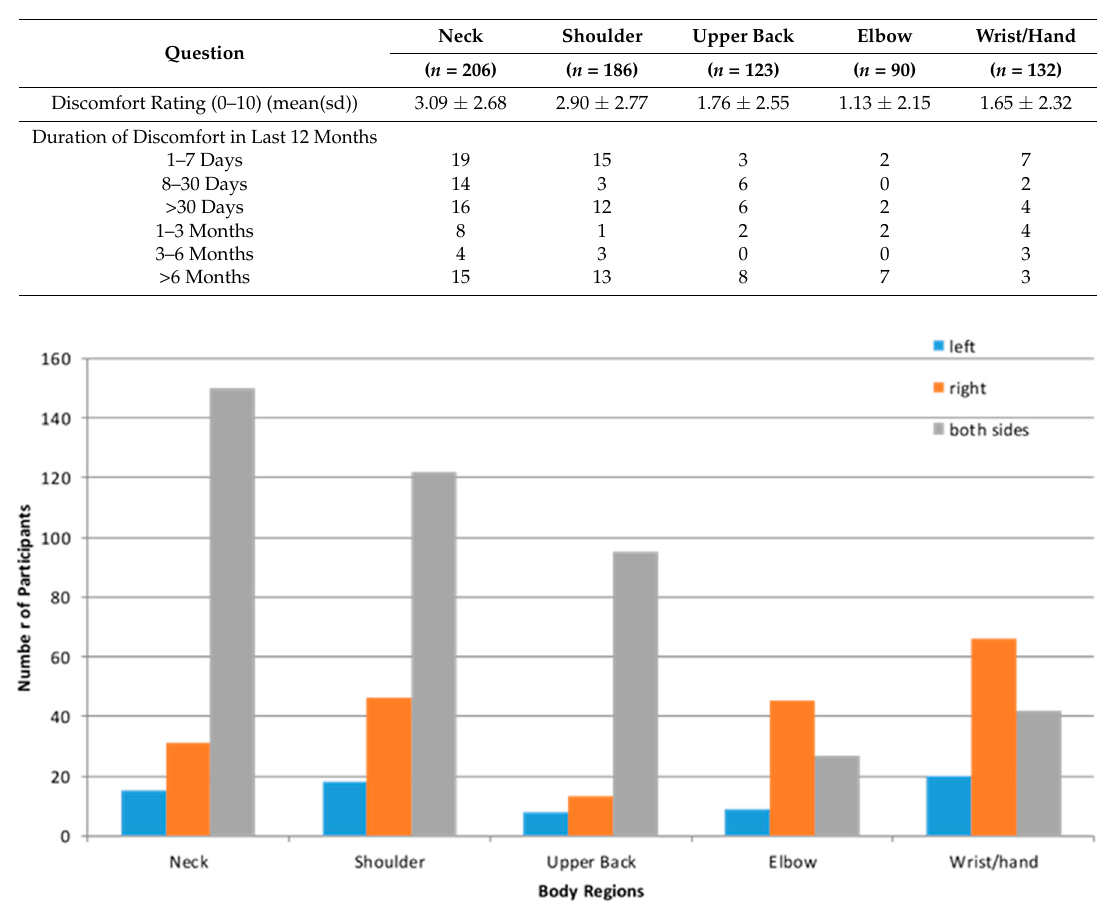
Table 4 . Musculoskeletal discomforts for different body regions. Table 4. Musculoskeletal discomforts for different body regions.